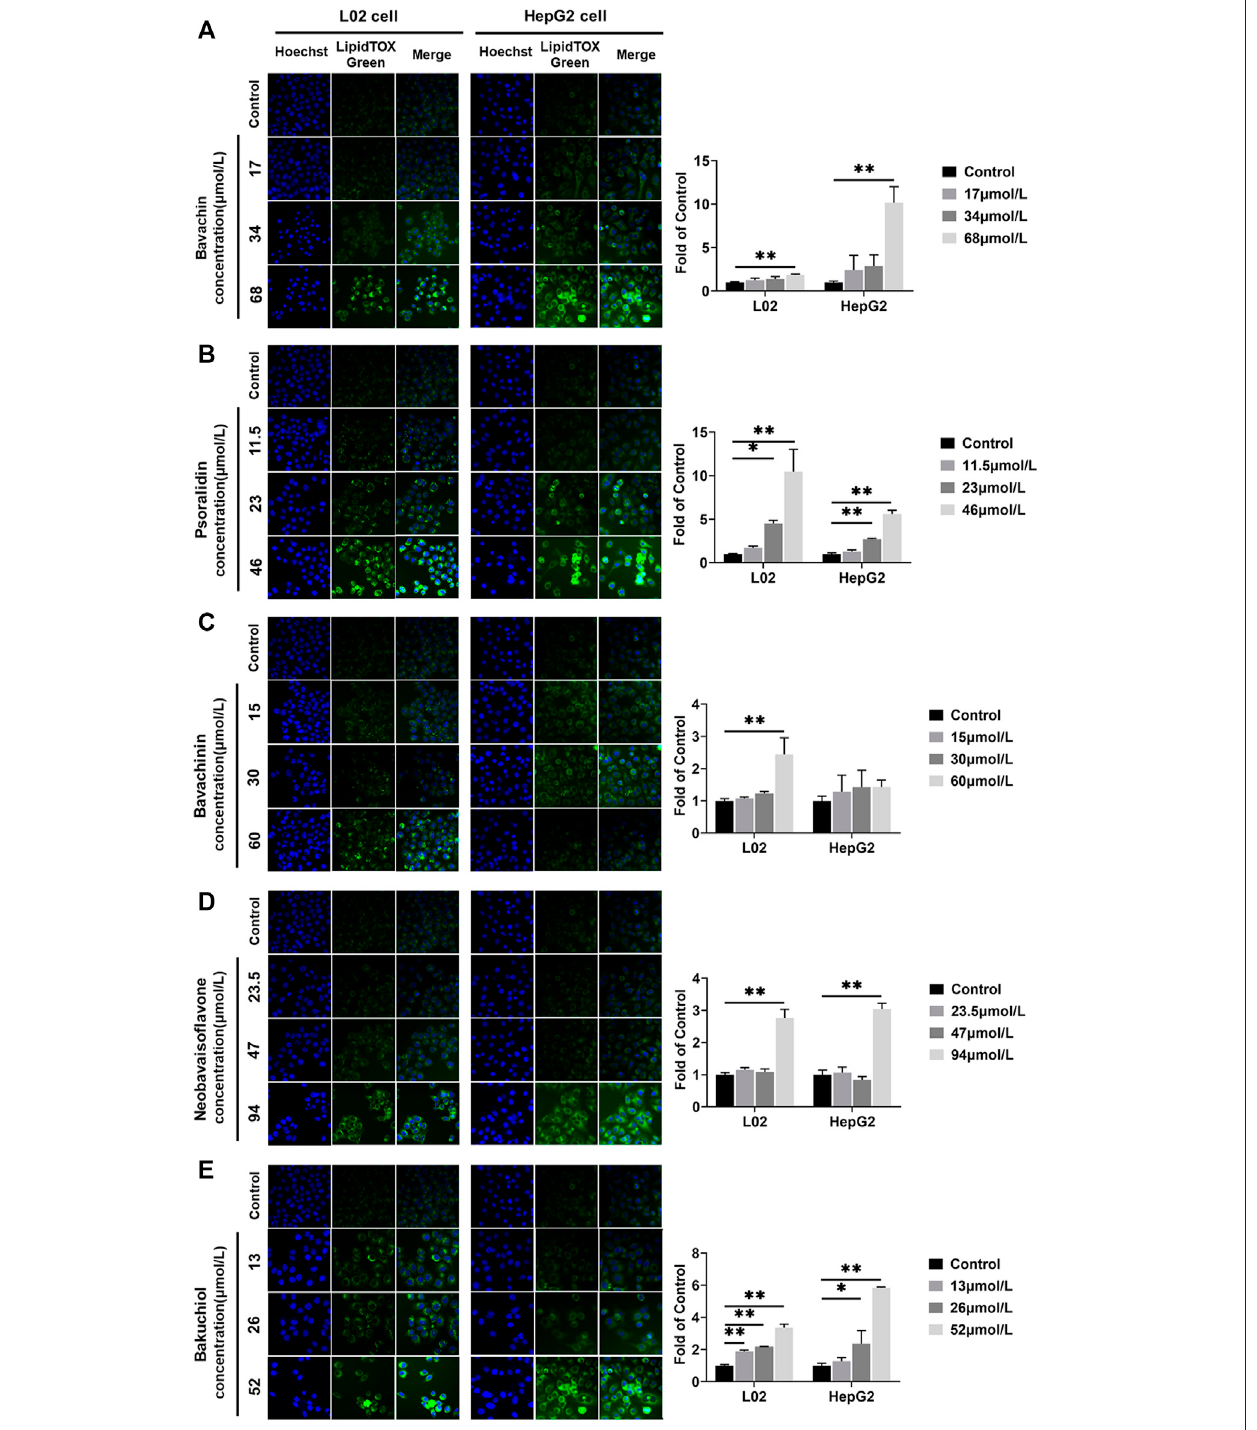
FIGURE 8 | Lipids were examined and quanti fi ed by HCS LipidTOX Green staining assays after exposure of L02 and HepG2 cells to the fi ve compounds. (A) Bavachin; (B) psoralidin; (C) bavachinin; (D) neobavaiso fl avone; (E) bakuchiol.Valuesarepresentedasmean ± SD, n (cid:1) 3.* p < 0.05,** p < 0.01versusthecontrolgroup. HCS, high-content screening.